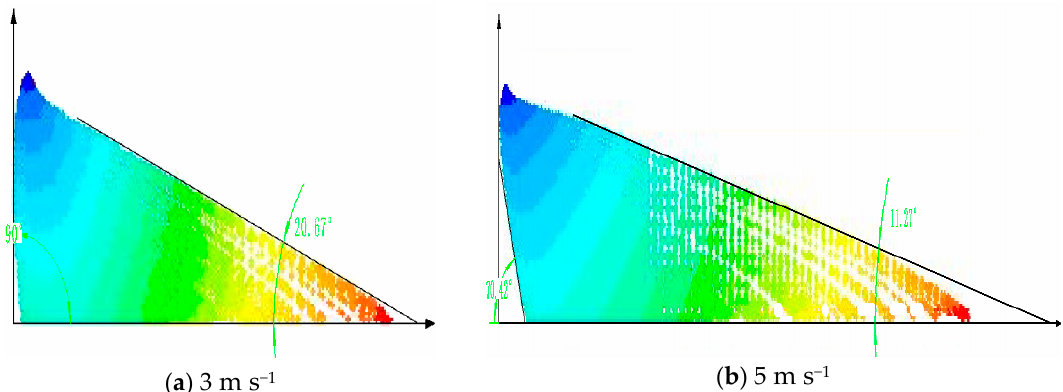
Figure 12. Droplet drift curve of different wind speed (3 and 5 m s − 1 ), X-axis means deposition area of 0 to 10m, and Y-axis means spray height. ( a ) The droplet angle was 90° and 20.67° at 3 m s − 1 , ( b ) The droplet angle was 70.42° and 11.27° at 5 m s − 1 .